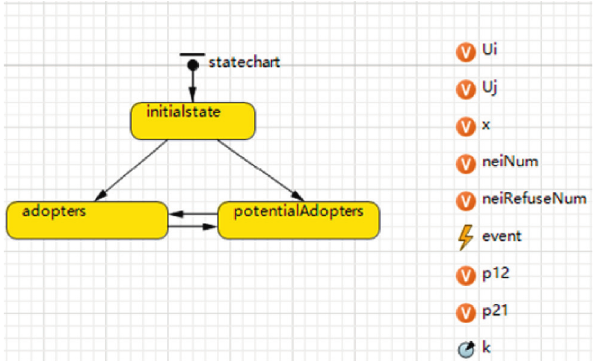
Figure 7: Person class